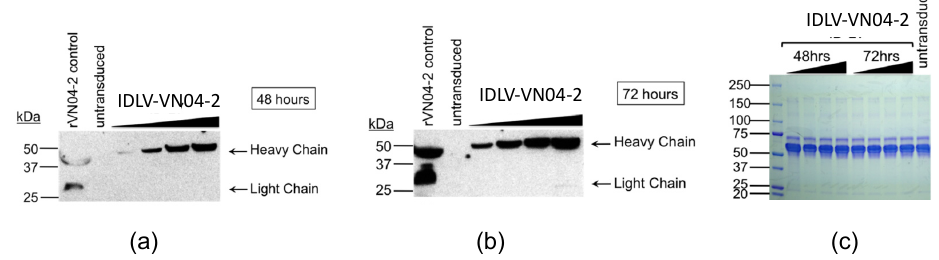
Figure 2. Time- and dose-dependent production of VN04-2 mAbs. Supernatants from 293T cells transduced with increasing doses of IDLV-VN04-2 (corresponding to 50 ng, 125 ng, 500 ng or 1 µg HIV-1 p24) or left untransduced, as a negative control, were collected at ( a ) 48 h or ( b ) 72 h post-transduction. Samples were separated on 4–15% SDS–PAGE gels and probed for human IgG by Western blot to determine VN04-2 production. Recombinant VN04-2 (rVN04-2) antibodies were run as a positive control for mAb detection. ( c ) Aliquots of the same samples depicted in panels ( a ) and ( b ) were run on a separate 4–15% SDS–PAGE gel and stained with Coomassie Brilliant Blue to visualize total protein.